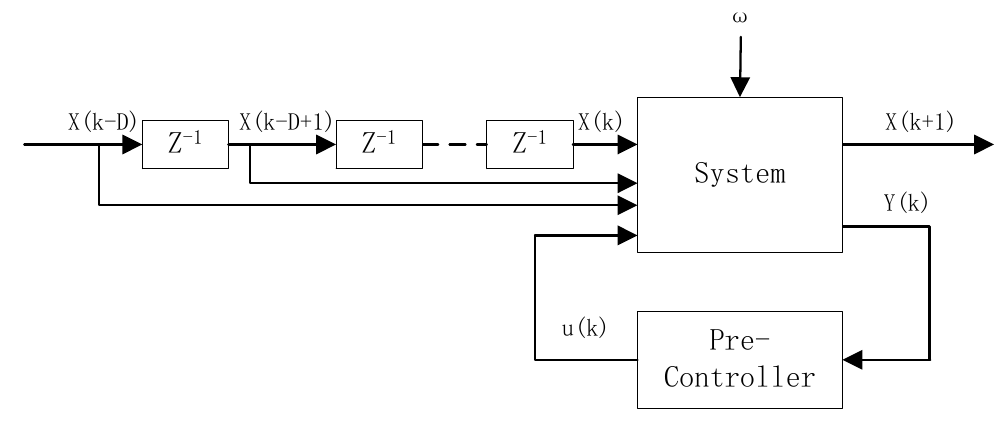
Figure 1. The structure of the